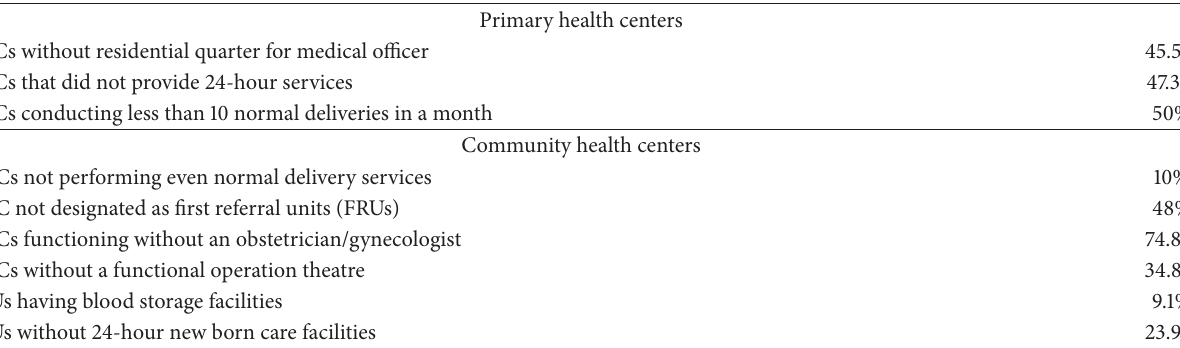
Table 6: Deficiencies in functioning of PHCs and CHCs in